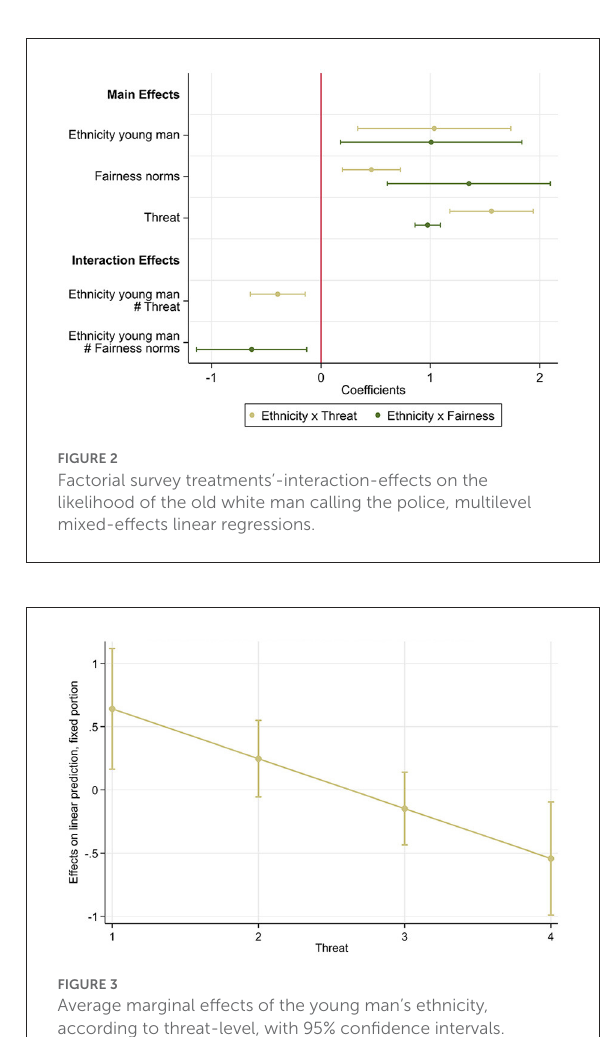
importance when examining everyday discriminating behavior, for example, among neighbors.